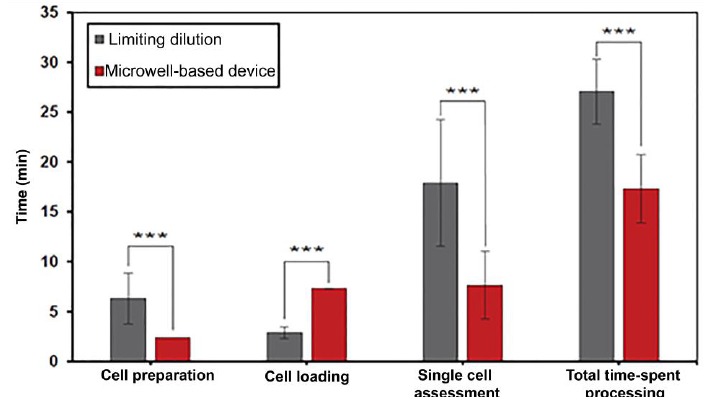
Figure 5. The time-spending using limiting dilution and a microwell-based microfluidic device. The data were based on each category, including preparation, cell loading, single-cell assessment, and total time-spent processing. Experimental data are reported as mean ± standard deviation ( n = 10). Means followed by the asterisk within columns indicate a significant difference at p < 0.001 using paired t -test. Each column was analyzed